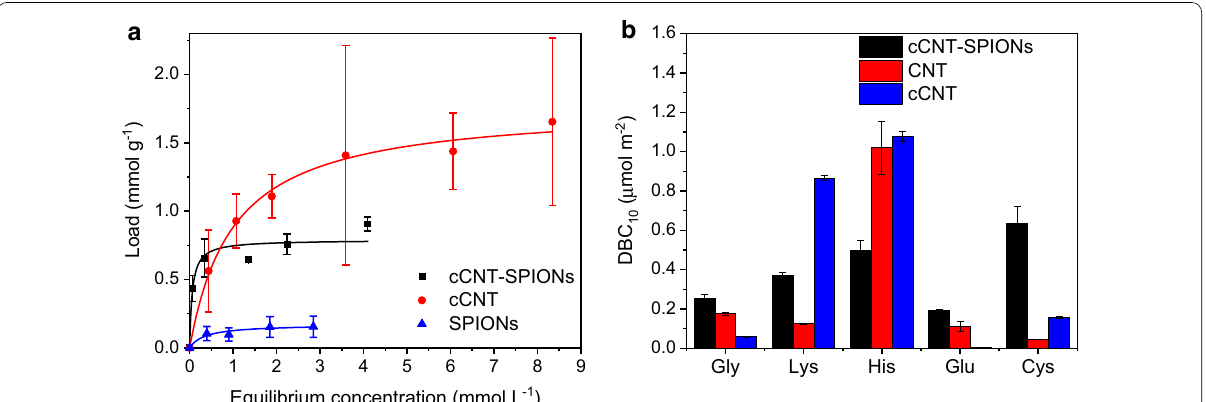
Fig. 6 Static binding capacities of l ‑lysine with cCNTs, cCNT‑SPIONs and SPIONs at pH 7.8 with 100 mM phosphate buffer ( a ). Dynamic binding capacities at 10% of the breakthrough of cCNT‑SPIONs, CNTs and cCNTs obtained from inverse chromatography experiments with different amino acids at pH 6 ( b